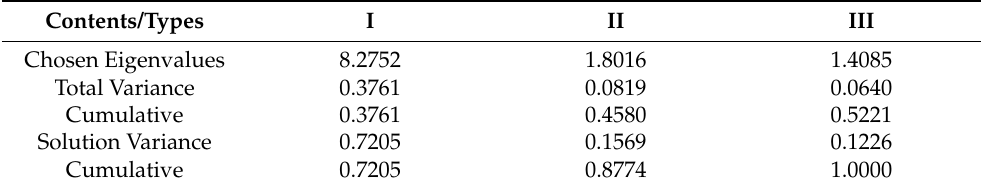
Table 3. Eigenvalues and explained variances in the 3-type